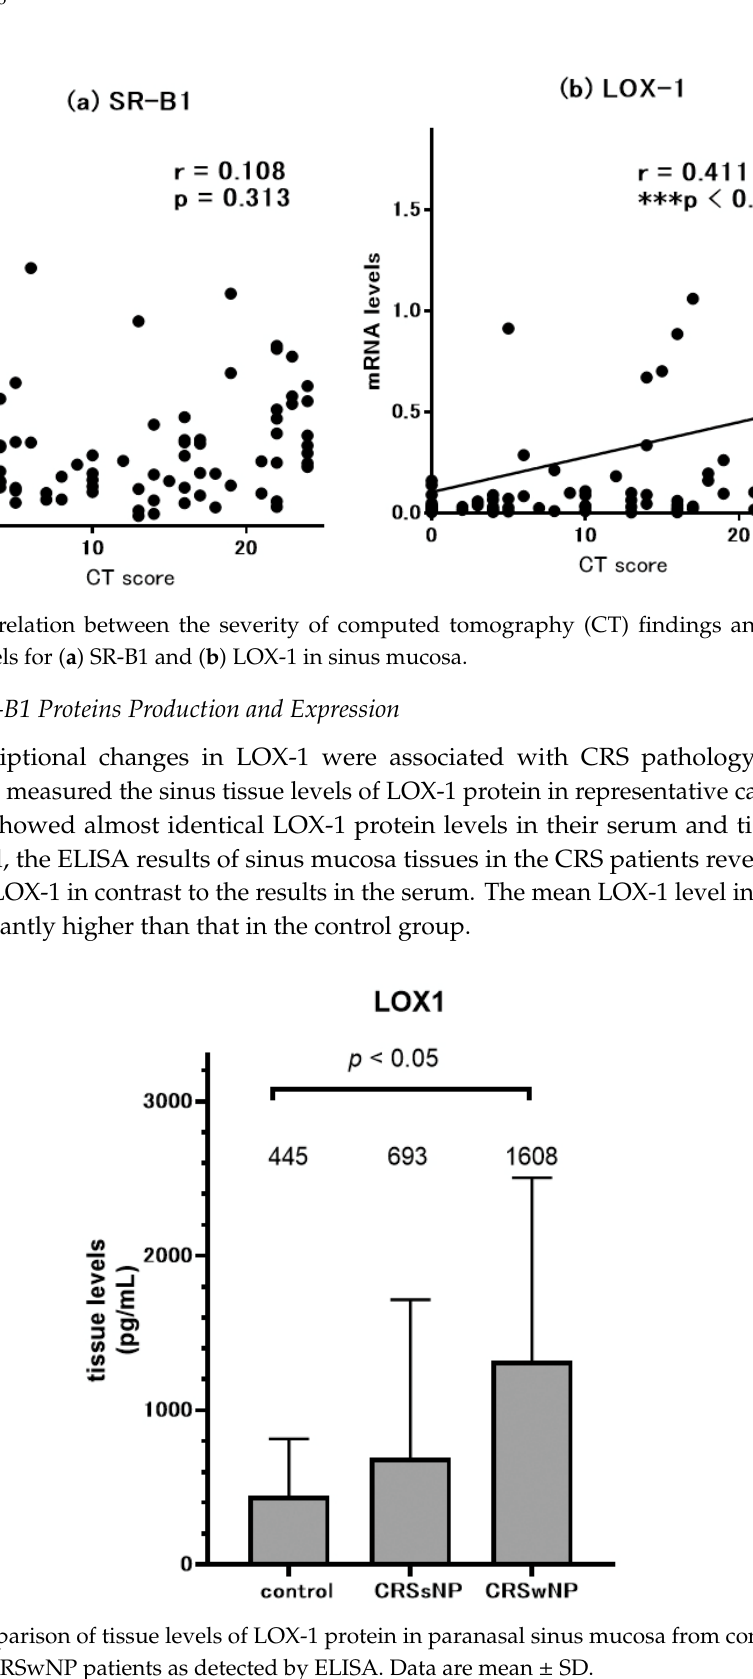
Figure 4. Representative immunohistological images showing SR-B1 ( a , b ), LOX-1 ( c , d ), and CD68 ( e , f ) expression in ethmoid sinus mucosa sampled from a CRSwNP patient. Vascular endothelial cells (arrowheads) are stained positively both for SR-B1 and LOX-1. In contrast, numerous submucosal inflammatory cells show intense positive staining for LOX-1 compared to that for SR-B1. Scale bar: 20 µm. 4. Discussion